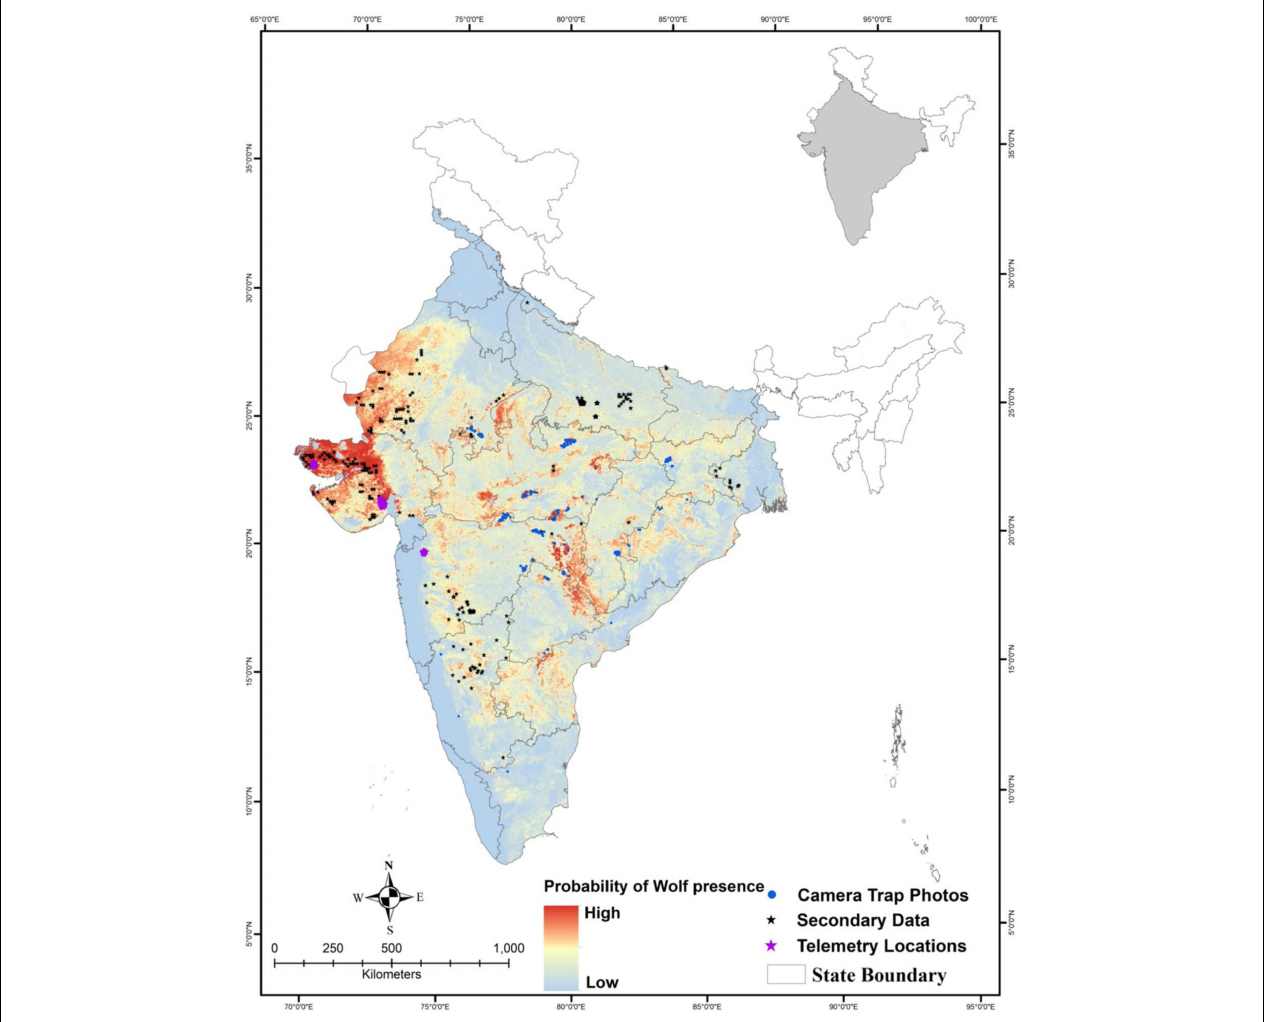
FIGURE 1 | Wolf distribution modeled in MaxEnt using presence locations with eco-geographical variables of human modification, climate, habitat, competing carnivores, and prey. Map inset shows region within India where wolf distribution was